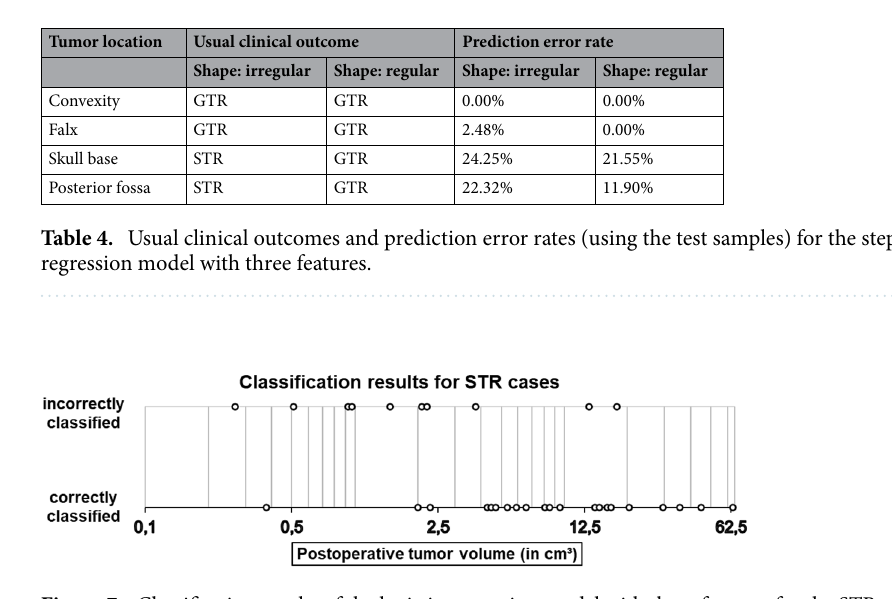
Figure 7. Classification results of the logistic regression model with three features for the STR cases, calculated with the test